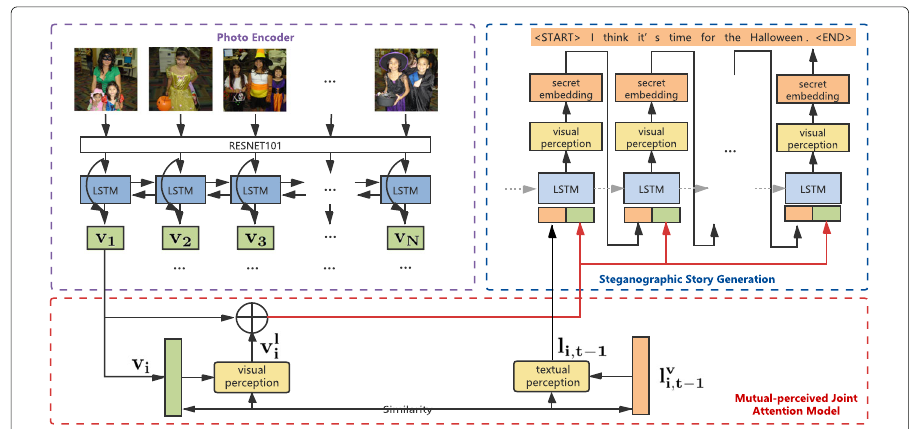
Fig. 2 Structure of steganographic visual story generation model with mutual-perceived joint